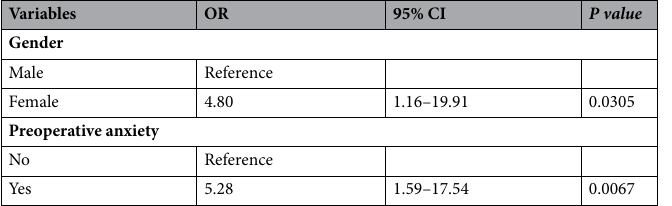
Table 5. Multivariate analysis of predictors for CPSP at 6 months. CPSP Chronic postsurgical pain. Adjusted for gender, age, BMI, occupation status, education level, marital status, smoking, alcohol drinking, hypertension, diabetes, coronary heart disease, ASA physical status, preoperative chronic pain, previous surgery, site of surgery, type of surgery, duration of surgery, MME consumption, number of drainage tube, tube retention time ,length of hospital stay, malignant tumor, preoperative anxiety, preoperative depression, expected postsurgical pain intensity, SFQ-s, SFQ-l, and trajectory model.